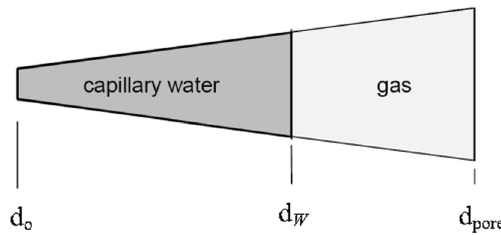
Fig. 3 Schematic representation of the border limits for the pore system with water (Van Breugel